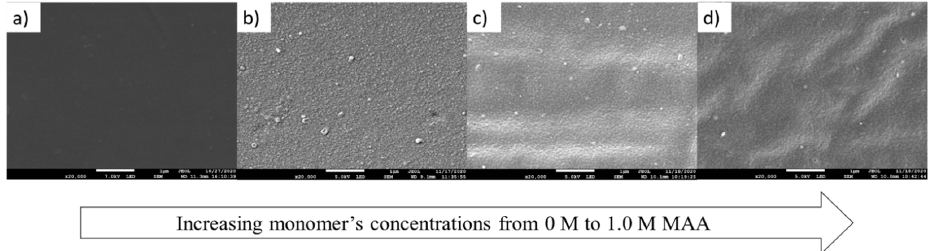
Figure 12. FESEM images (20,000× magnification) of the top surface of the membranes: ( a ) NF2PES, ( b ) 0.1 MAA3, ( c ) 0.5 MAA3 and ( d ) 1.0 MAA3.